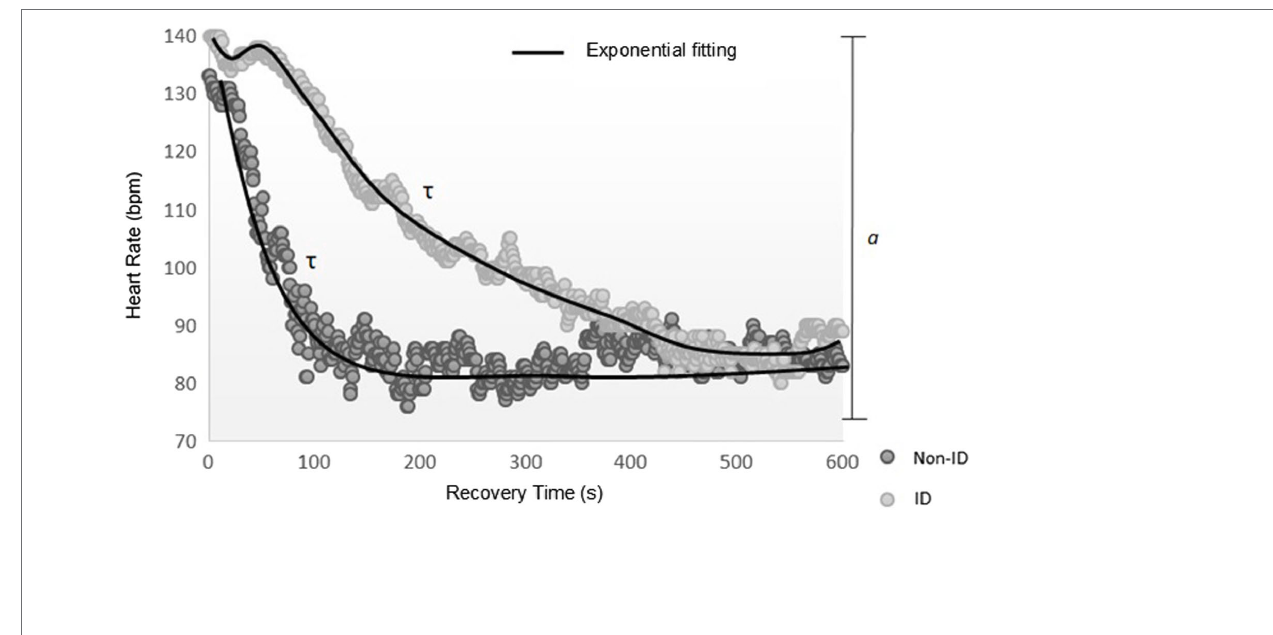
FIGURE 1 | Representation of the HR recovery response after the 6-min walking test in one participant with ID and a non-ID participant. Data were fitted by an exponential function to characterize the dynamic response of HR recovery. HR, heart rate; τ , time constant; a, heart rate amplitude; ID, older adult with intellectual disability; and Non-ID, older adult without intellectual